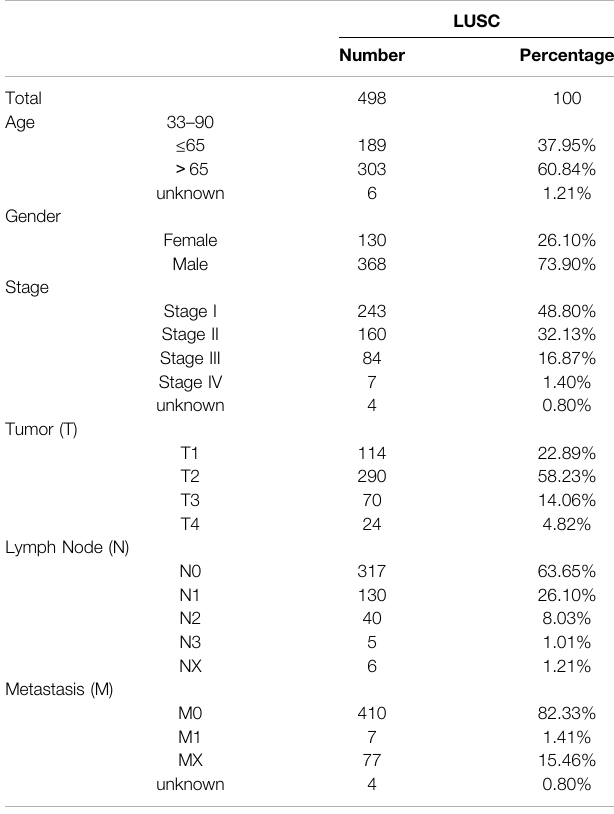
TABLE 1 | Clinicopathological characteristics of LUSC patients in the TCGA